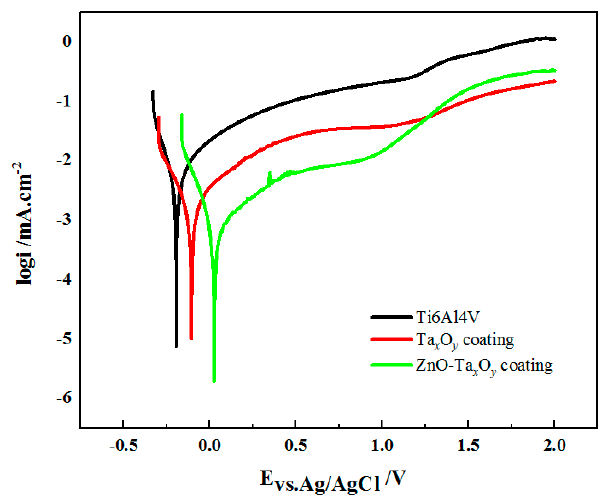
Figure 10. Potentiodynamic polarization curves of the uncoated and coated samples in SBF.